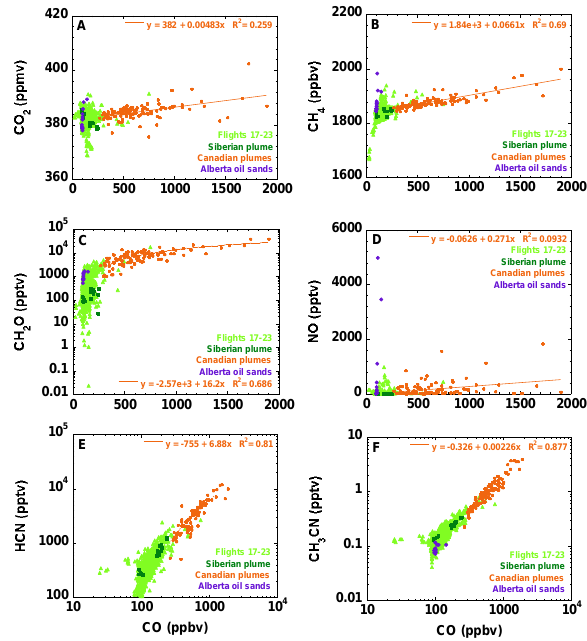
Fig. 4. Scatter plots of CO vs. (a) CO 2 , (b) CH 4 , (c) CH 2 O, (d) NO, (e) HCN and (f) CH 3 CN for all 947 whole air samples collected during ARCTAS-B (Flights 17-23). Dark green squares: Siberian boreal forest fire plume ( n = 13); orange circles: Canadian boreal forest fire plumes ( n = 105); purple diamonds: Alberta oil sands plume; light green triangles: rest of Flight 17-23.